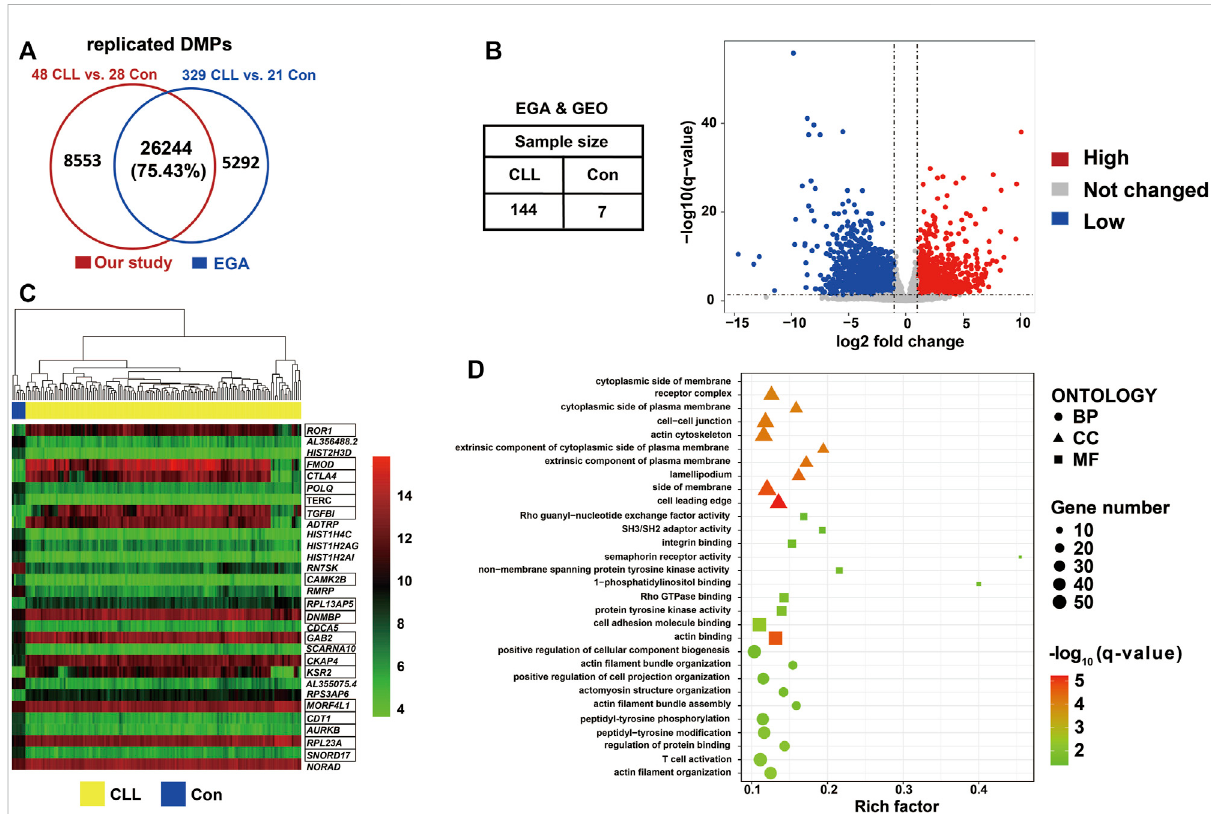
FIGURE 4 DMEGs identi fi ed between CLL patients and controls (A) Venn diagram showed the number of replicated DMPs. Replicated DMPs (N = 26,244) overlapped using our dataset of 48 CLL patients and 28 healthy control compared to DMPs identi fi ed datasets from EGA of 329 CLL patients and 21 healthy control. More than 75% DMPs from our study were also found in DMPs identi fi ed in EGA. (B) Volcano plot showed the differentially expressed genes through transcription analysis using DESeq2. Datasets were required from EGA and GEO with a total of 144 CLL patients and seven healthy controls. DEGs (N= 5,104) wereselectedwiththe criterion ofq-value < 0.05and |foldchange| > 2using DESeq2. (C) Heatmapshowed the expression value the top 30 DEGs. The hierarchical clustering analysis was performed using the normalized counts from RNAseq data.